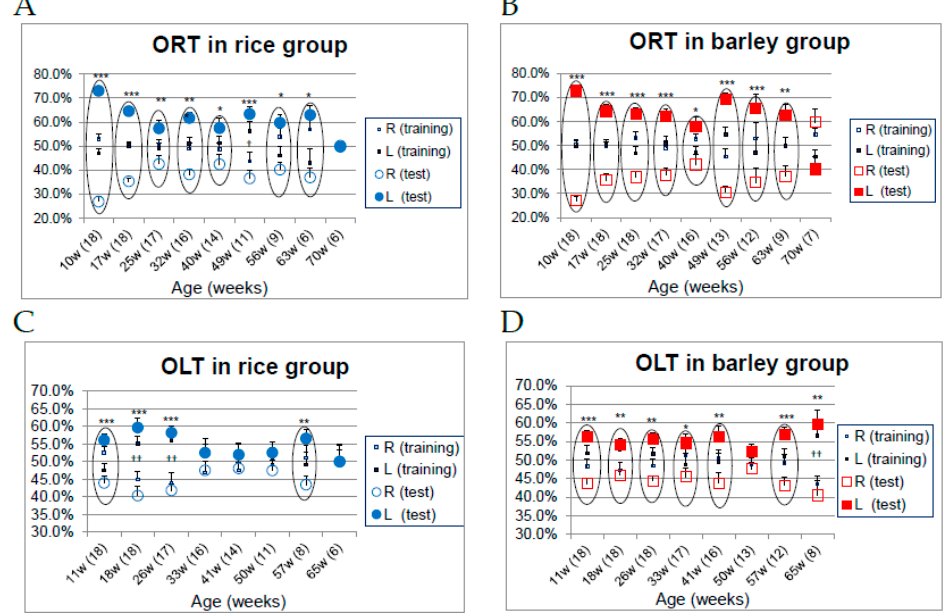
Figure 8. Changes in object recognition (long-term object memory) and spatial recognition (long-term